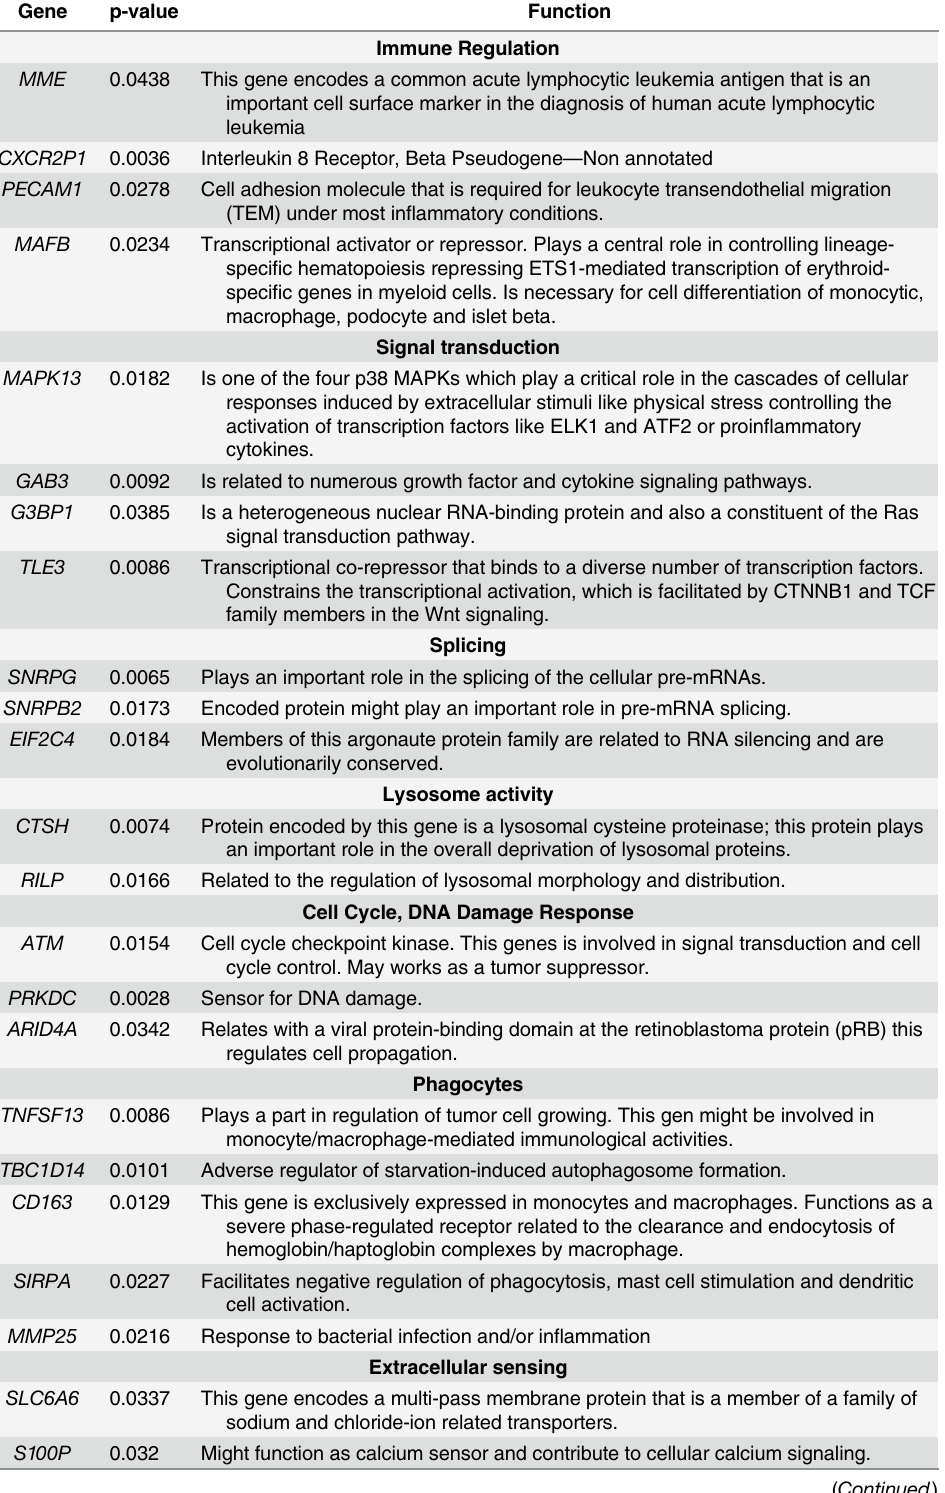
Table 1. Timepoint-by-population interaction genes at p < 0.05 group